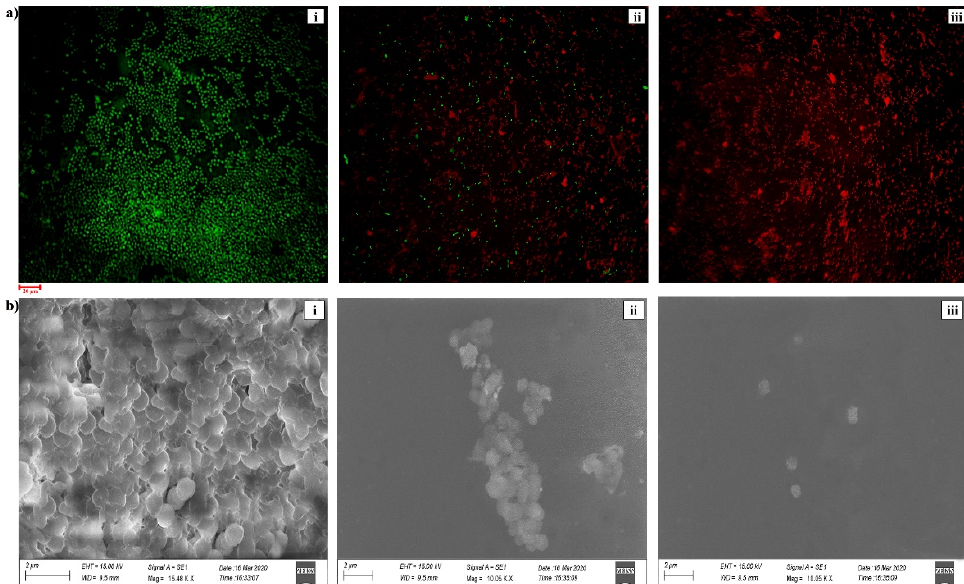
Figure 2. ( a ) CLSM image of bacterial live/dead assay on MRSA provided by HPAEtOAc crude extract: (i) control, (ii) treated at 75 µg/mL, and (iii) treated at 150 µg/mL concentration on MRSA. ( b ) SEM image of bacterial alive/dead assay on MRSA provided by HPAEtOAc crude extract: (i) control, (ii) treated by 75 µg/mL, and (iii) treated by 150 µg/mL concentration on MRSA.